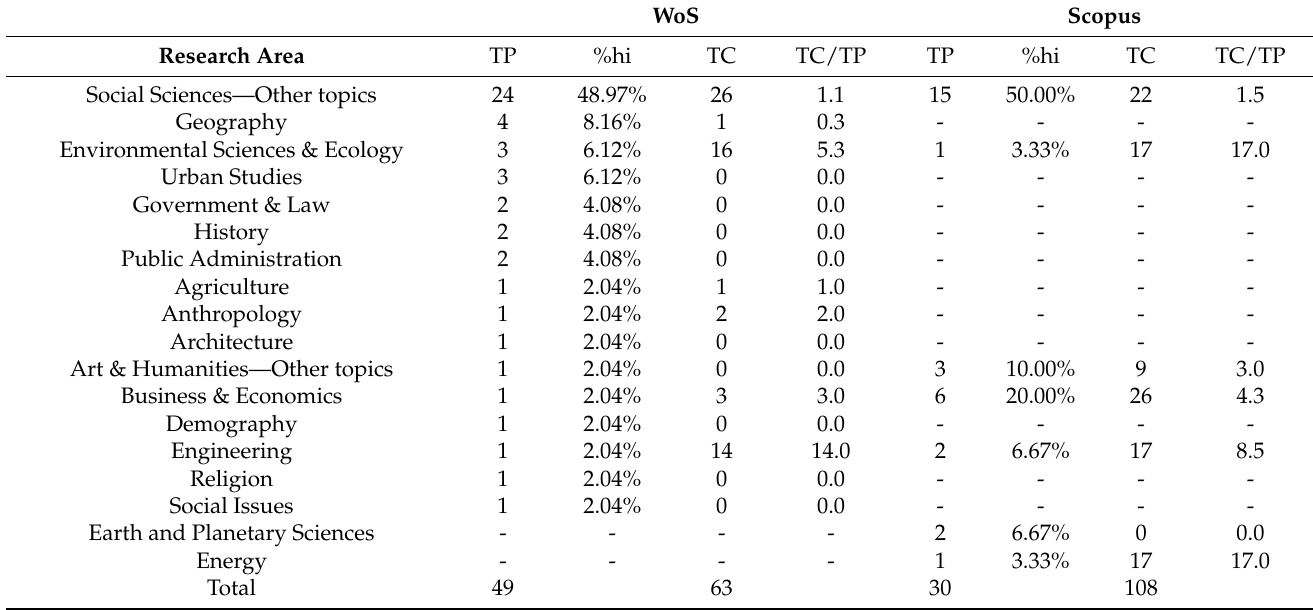
Table 9. Number of articles per research area according to WoS and Scopus